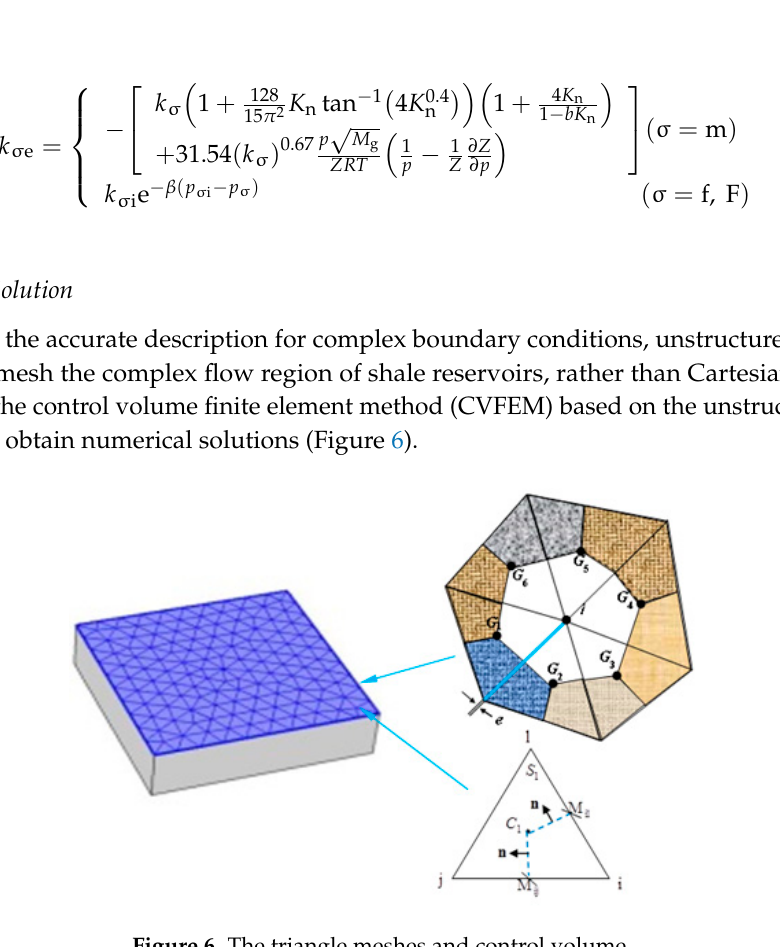
Figure 6. The triangle meshes and control volume.